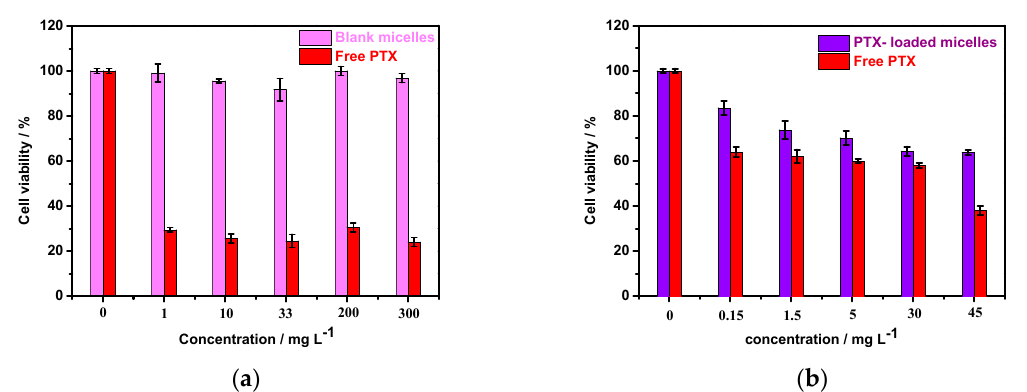
Figure 8. Cytotoxicity of blank and PTX-loaded micelles against 3T3 cells ( a ) and MCF-7 cells ( b ) for 48 h. 48 h.